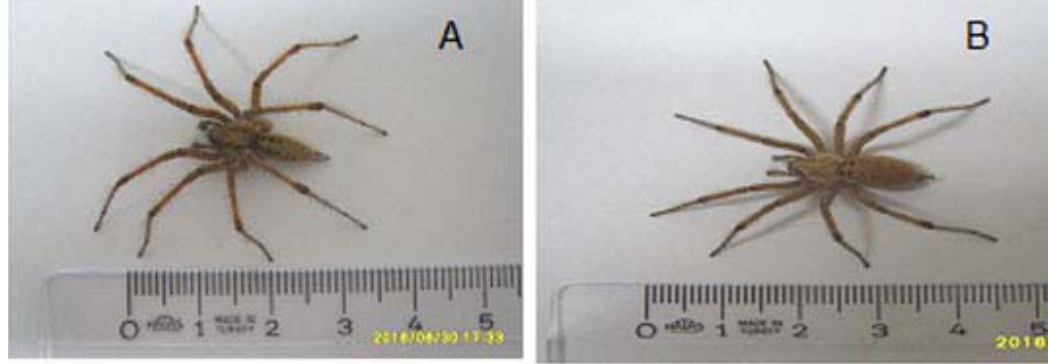
Figure 1. Dorsal view of male ( A ) and female ( B ) of A.